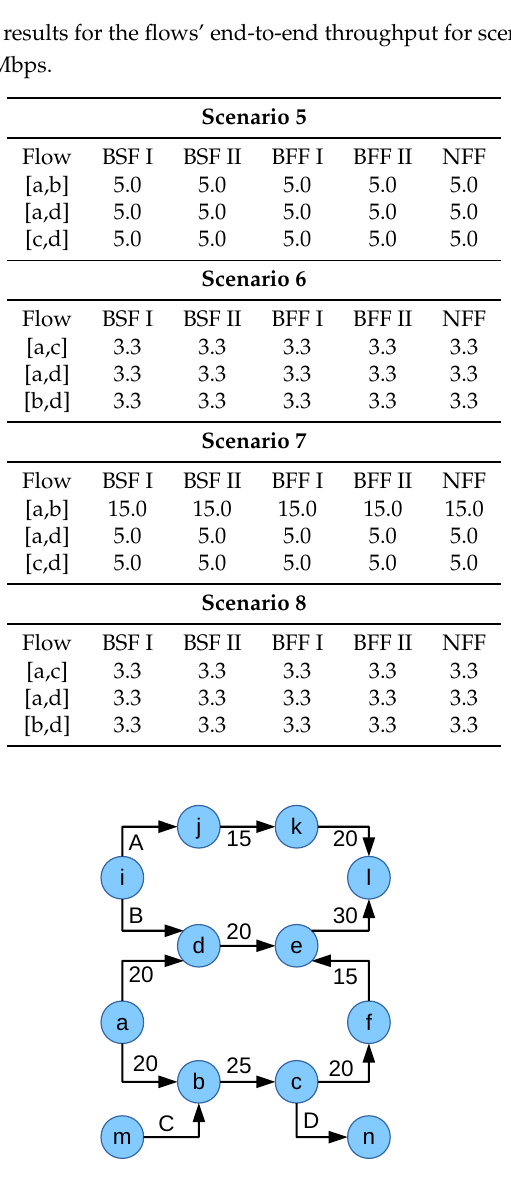
Figure 16. Topology of scenarios 15 to 18: 2 two-path connections i-l and a–f with shared bottleneck links d–e and b–c. The numbers specify the link speeds in Mbps. Scenarios 15 and 16: A = B = C = 10, D = 15; scenarios 17 and 18: A = 30, B = 40, C = 10, D = 35.